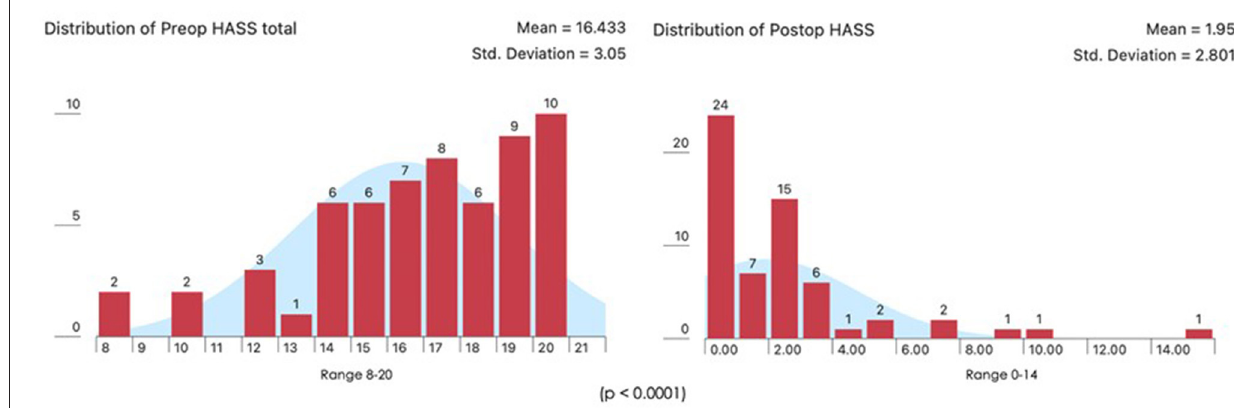
FIGURE 3 | Pre-operative vs. post-operative HASS.